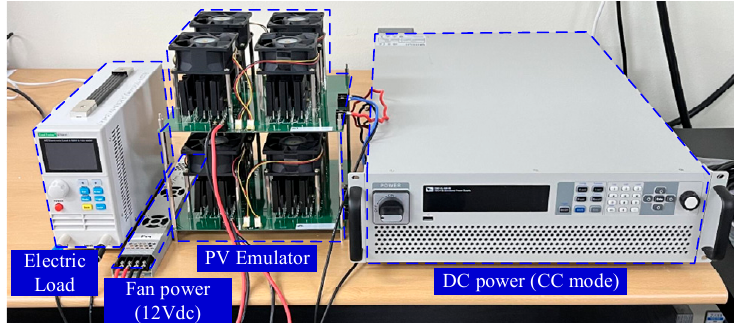
Figure 14. Experiment setup of the proposed PVE.